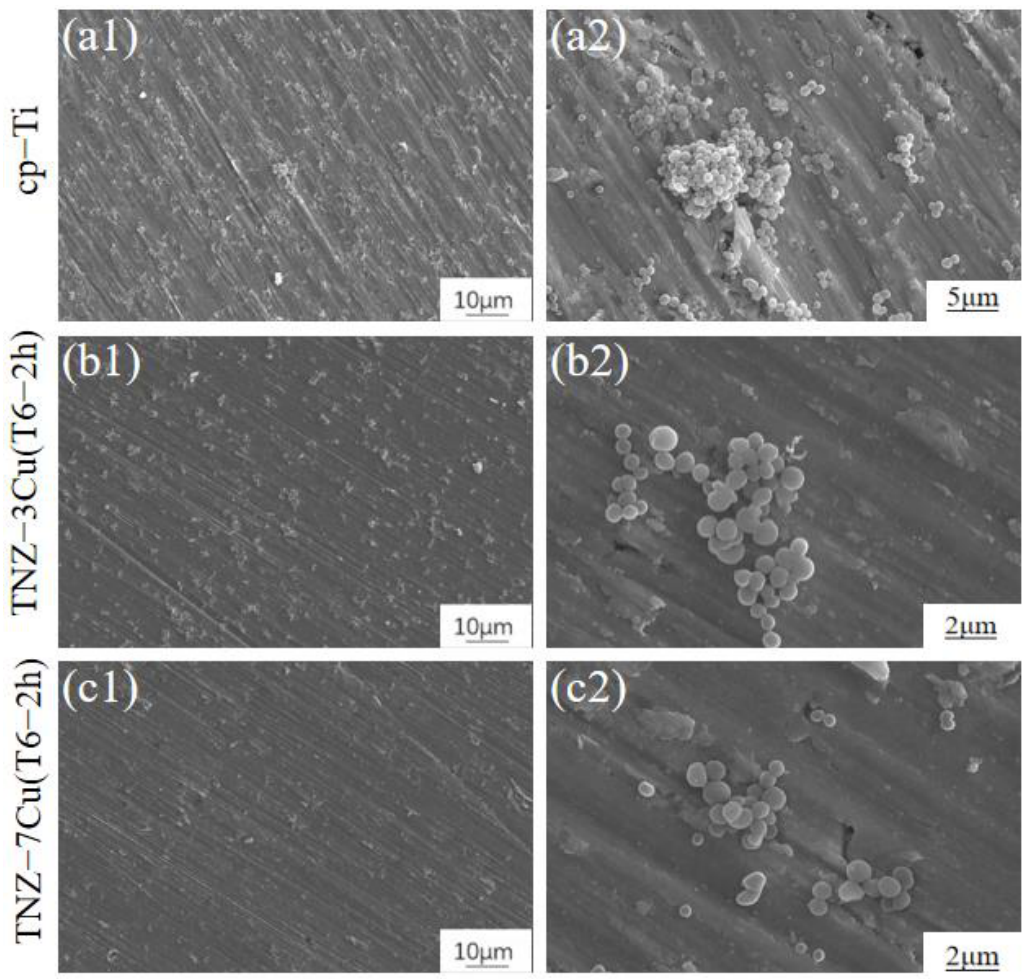
Figure 12. Morphology of S. aureus cultured on the samples surface for 24 h. ( a 1, a 2) cp-Ti; ( b 1, b 2) TNZ-3Cu(T6-2h); ( c 1, c 2) TNZ-7Cu(T6-2h).